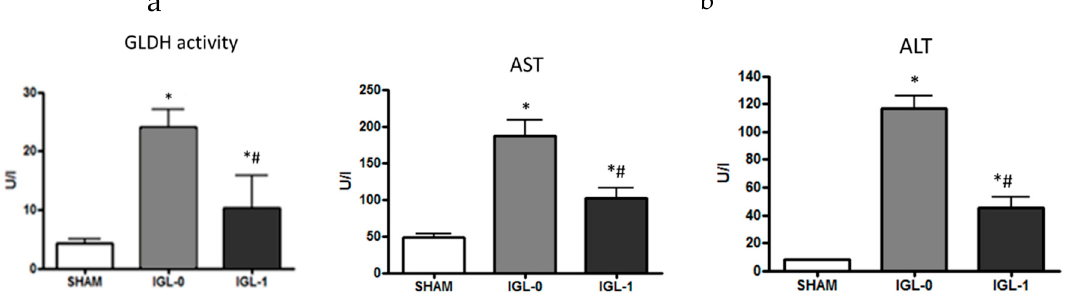
Figure 1. Differences between IGL-0 and IGL-1. ( a ) Mitochondrial damage as glutamate dehydrogenase (GLDH) activity. ( b ) Liver damage as transaminases aspartate aminotransferase (AST) and alanine aminotransferase (ALT). Groups are divided into SHAM (no treatment), fatty livers preserved 24 h at 4 °C in IGL-0 solution (without PEG35) and commercial IGL-1 solution. Results are expressed as mean ± SEM ( n = 6). * p < 0.05 significant differences as compared to SHAM; # p < 0.05 as compared to IGL-0.